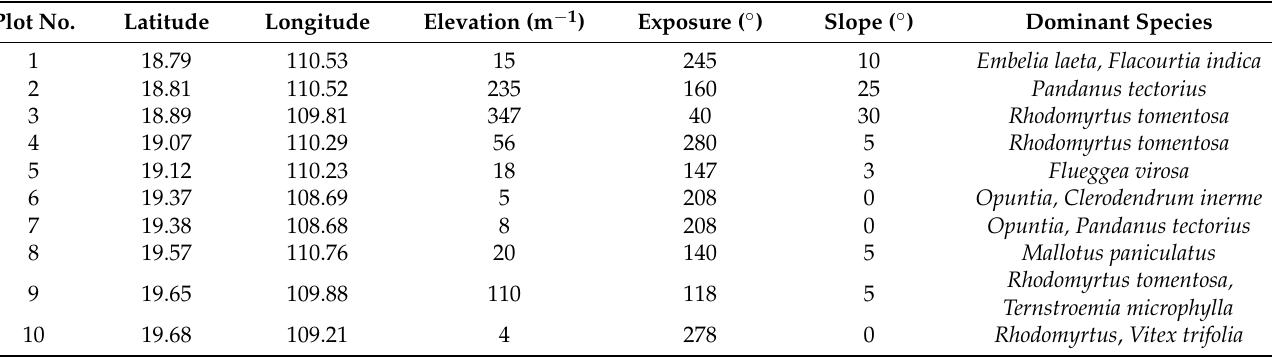
Table 1. The physical characteristics of the sample